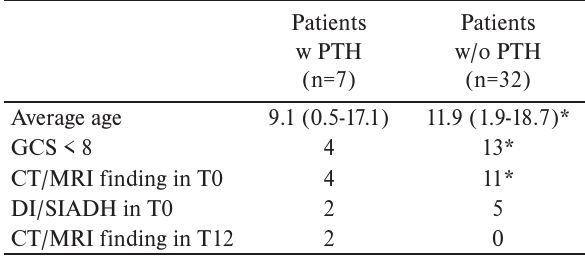
Table 4. Comparison of patients with and without hormonal